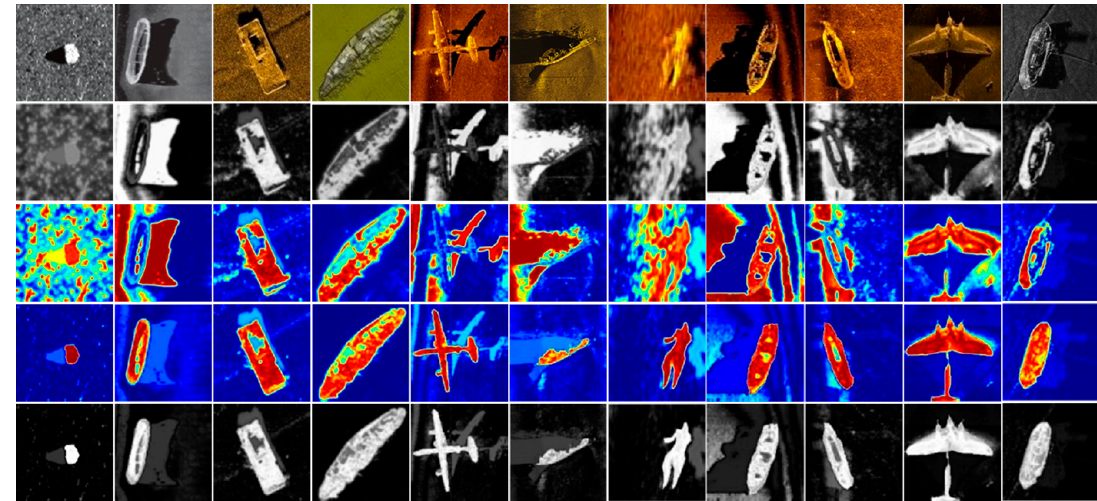
Figure 7. Comparison of LBM evolution tests. The first row: Original sonar images. The second to the third rows: Random initial LBM segmentation results (line 3 shows the same result color map as line 2). The fourth to the fifth rows: Segmentation with our LBM strategy.